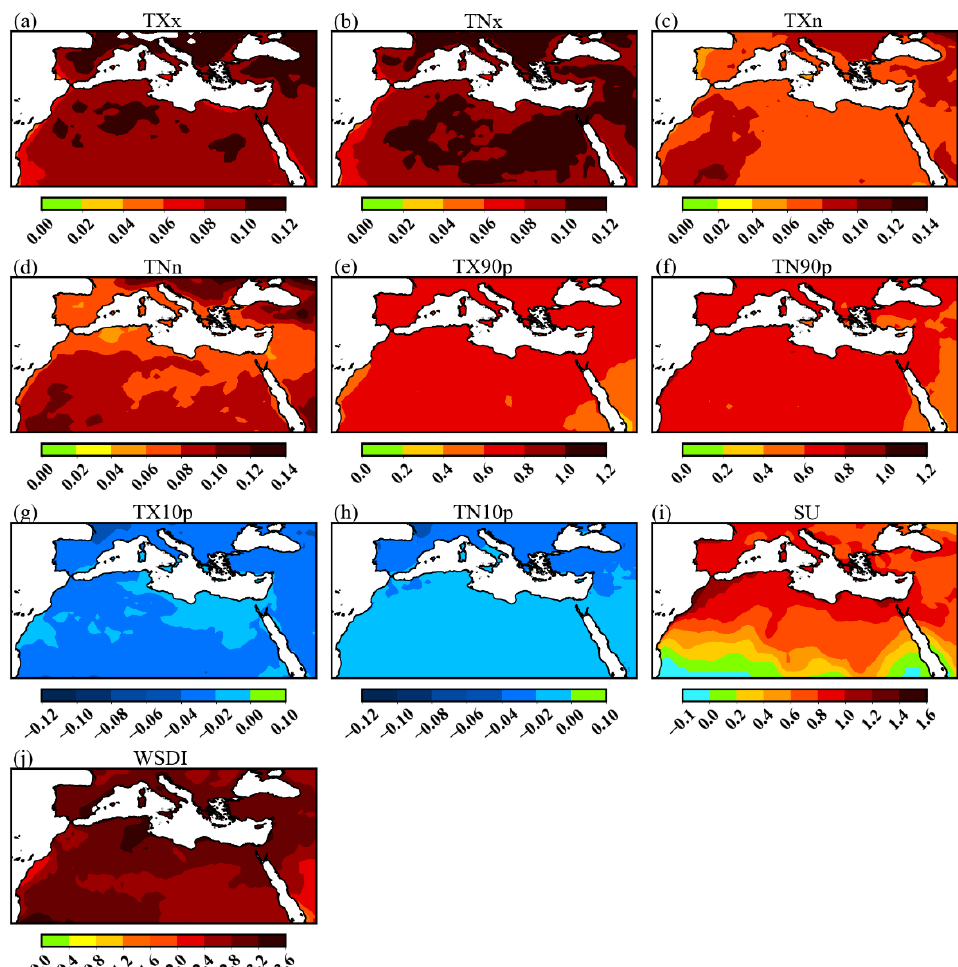
Figure 13. Spatial trends of extreme temperature from the multi-model ensemble mean of CMIP6 GCMs bias-adjusted data for the mid-future (2041–2070) relative to the baseline period (1995–2014) for the SSP5-8.5 scenario. The indices reflect the intensity (TXx, TNx, TXn and TNn) ( a – d ), frequency (TX90p, TN90p, TX10p, and TN10p) ( e – h ) and duration (SU and WSDI) ( i , j ) of the extreme